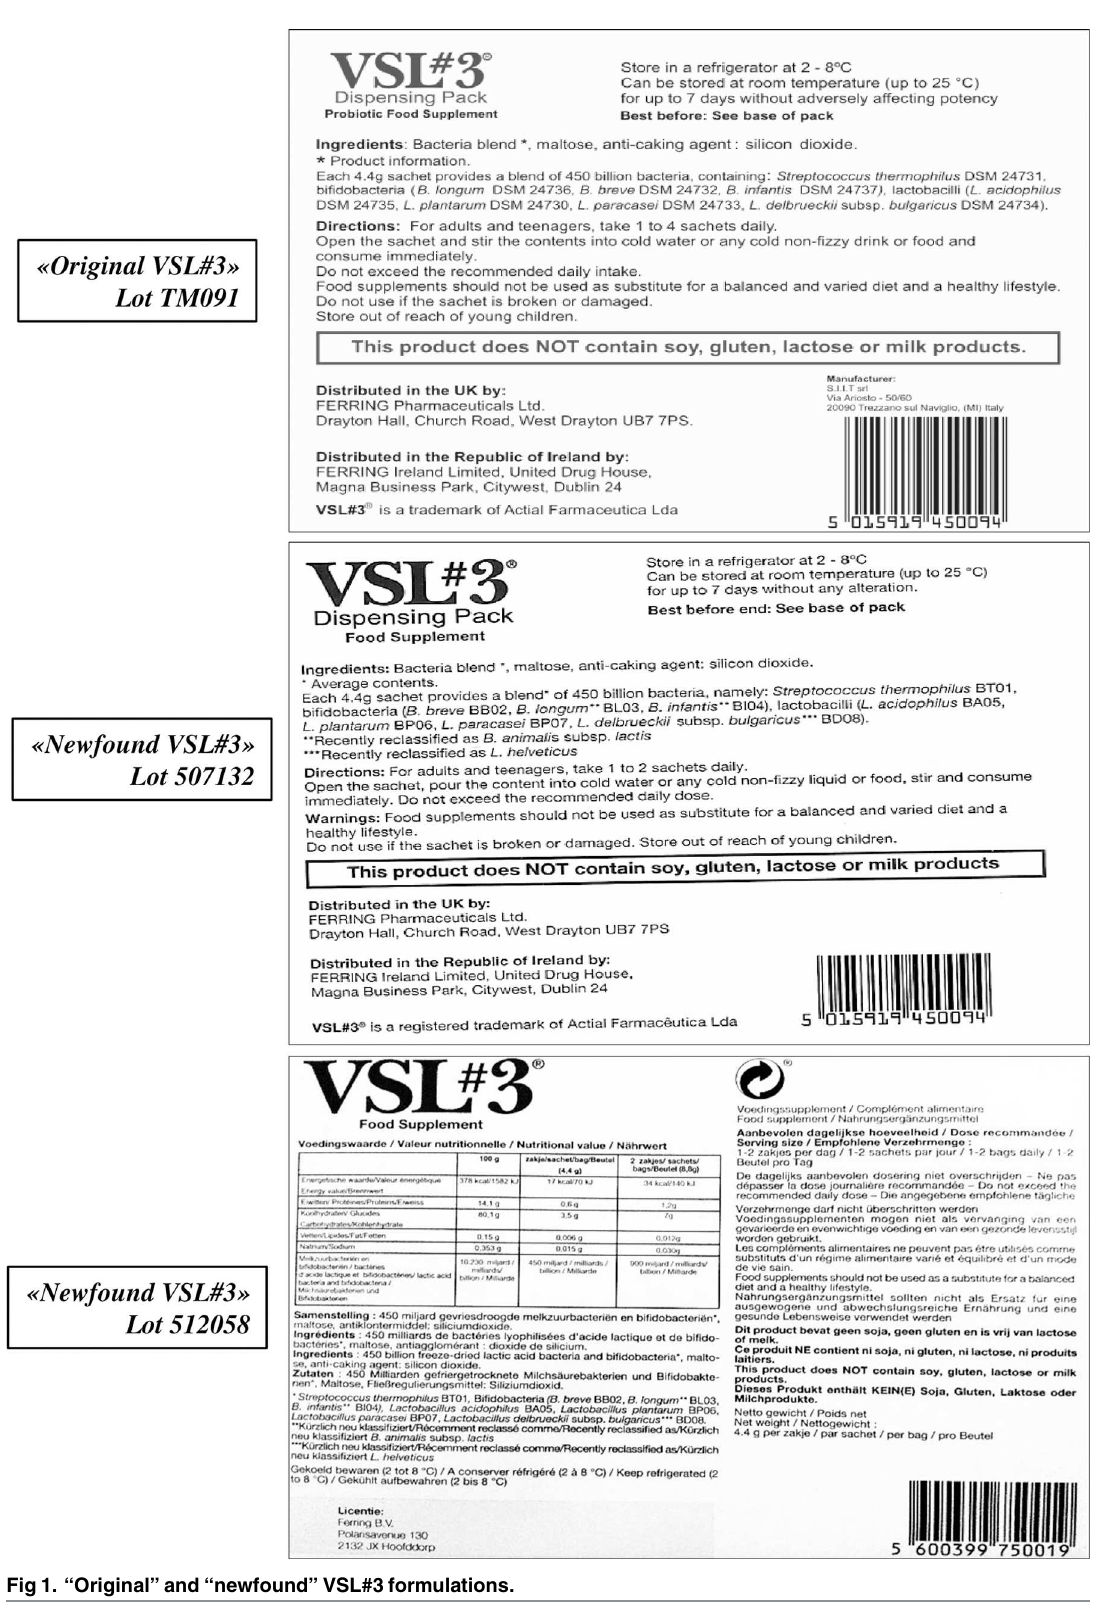
Fig 1. “Original” and “newfound” VSL#3 formulations.